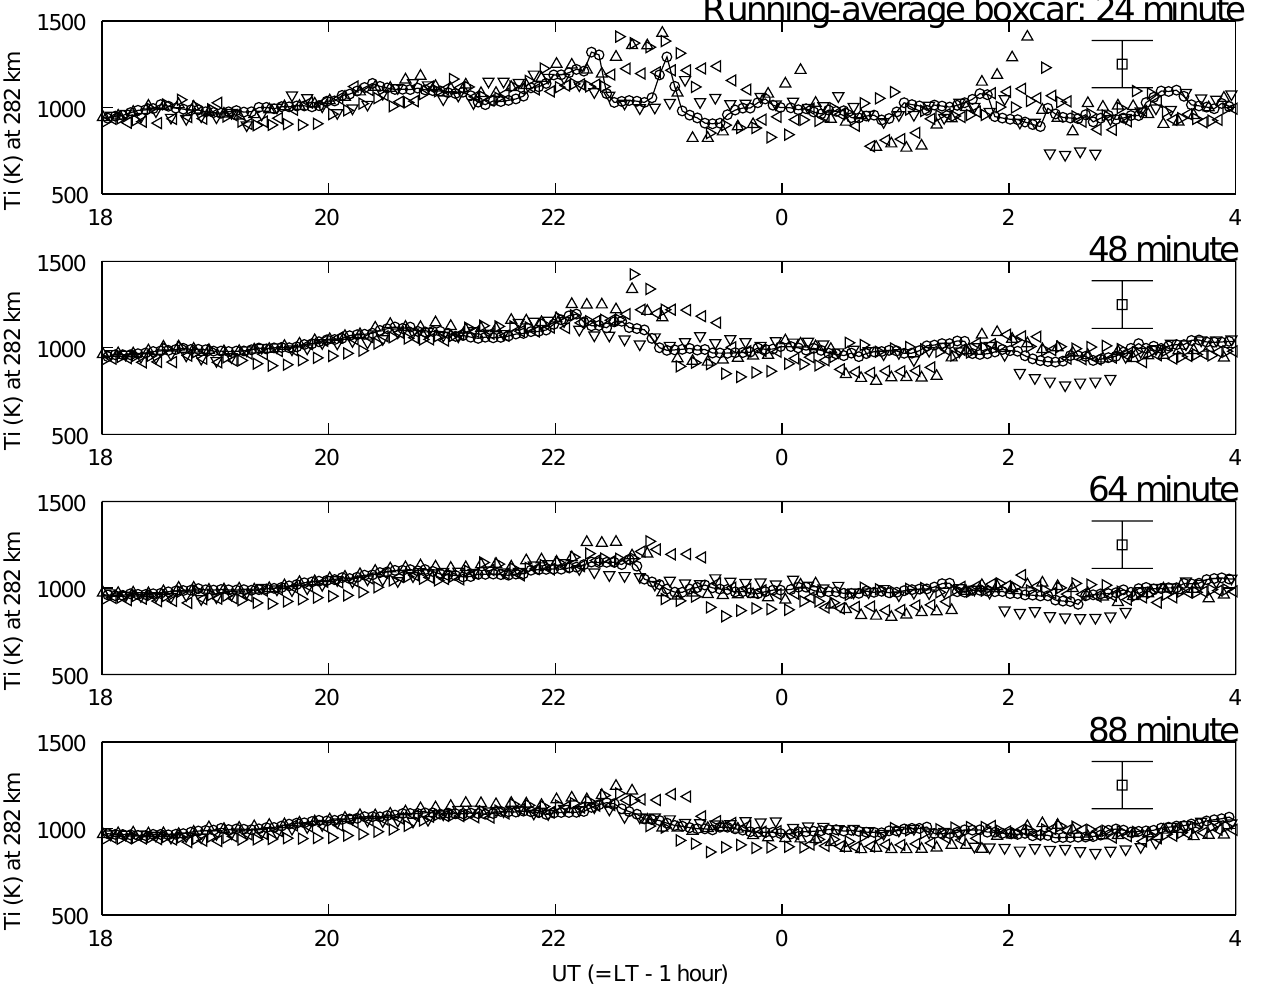
Fig. B1. Temporal variations in the ion temperature at 282km height from 18:00 to 04:00UT on 9–10 September 2004 during the EISCAT experiment. There are five kinds of ion temperature in each panel: data obtained for the tristatic measurement at 106km (upward-pointing triangle), at 109km (rightward-pointing triangle), at 114km (downward-pointing triangle), at 120km (leftward-pointing triangle), and at 282km (solid curve with open circle). The running-average method with boxcar window lengths of 24, 48, 64, and 88min (from top to bottom) is applied to each ion temperature. Vertical bar is the mean measurement uncertainty of the F -region ion temperature with ± 1 σ from 18:00 to